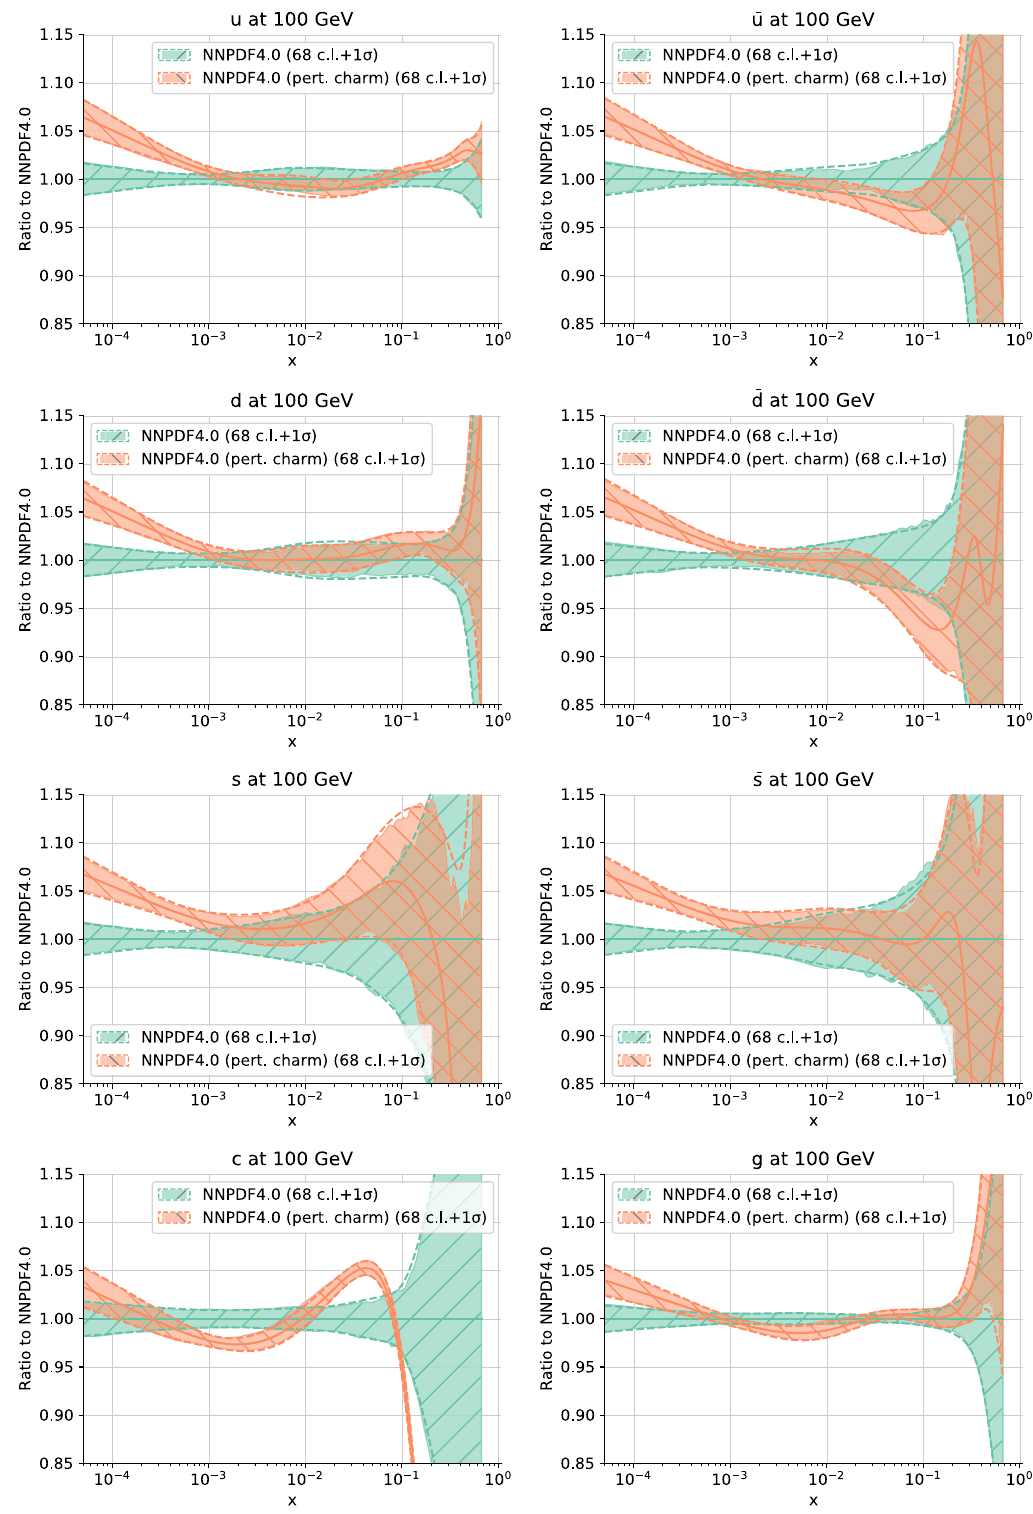
Fig. 51 Same as Fig. 33, comparing to the baseline PDFs in which charm is not independently parametrized but rather determined by perturbative matching. The charm mass is taken to be m c = 1 . 51 GeV in both